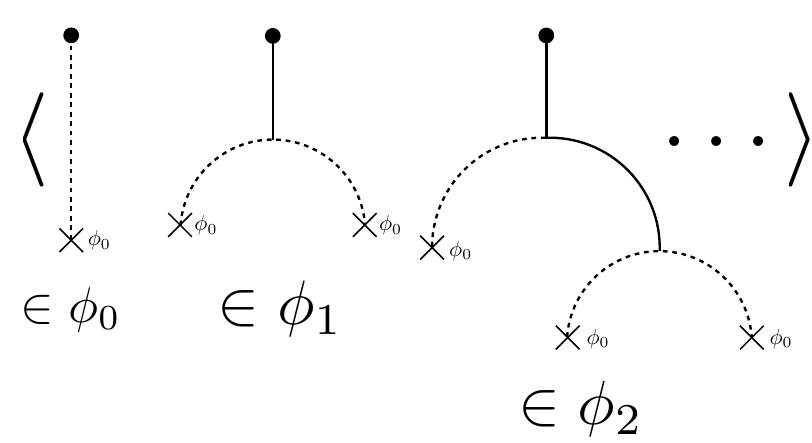
Figure 5 . A schematic representation of eq. (5.1). The graph labelled (cid:30) 0 represents those contri- butions arising from the direct insertion of the free-(cid:12)eld solution, (cid:30) 0 , which can be generalized to the inhomogeneous source term in eq. (5.2). The middle graph shows those evaluated at ( (cid:21) ) in O classical perturbation theory, and the last graph is a representative of those at ( (cid:21) 2 ). There may be O multiple contributions at each order (the n i in eq. (5.1)) and at higher orders. The interpretation of is that it joins up the dangling factors of each classical solution pairwise in all possible hi (cid:2) combinations, evaluating them as the anticommutator propagator, G +